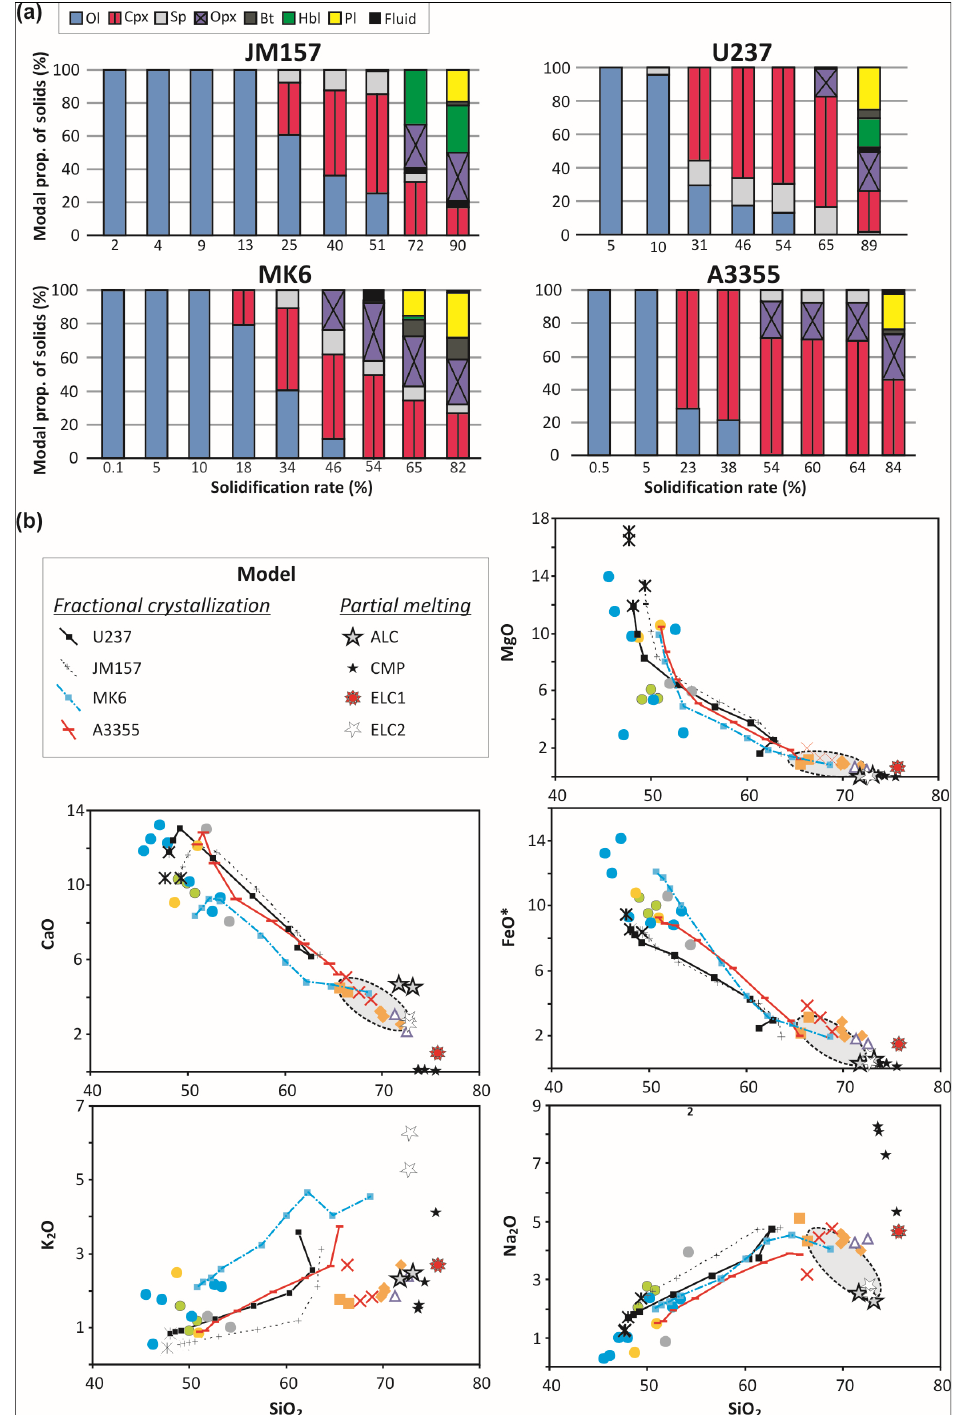
Figure 12. ( a ) Results of fractional crystallization of four possible parental magmas: JM157 [31], U237 [16], MK6 (MOD) and A3355 (MPD). Bar diagrams represent modal proportion of solids at each step of crystallization (mineral abbreviations after Whitney and Evans [30]).( b ) Harker diagrams of the rocks from the Corno Alto (symbols as in Figure 8) and the obtained model melt compositions from fractional crystallization (JM157, U237, MK6 AND A3355) and partial melting (ALC, CMP, ELC1 and ELC2) simulations.The grey fields represent rocks composition formed by the combination of partial melting and fractional crystallization processes. Note that FeO* represents all iron as Fe 2+ . In the first approach, we evaluated the effect of fractional crystallization and evolu- tion of an initial mafic magma. The model was run using the software Rhyolite-Melts v